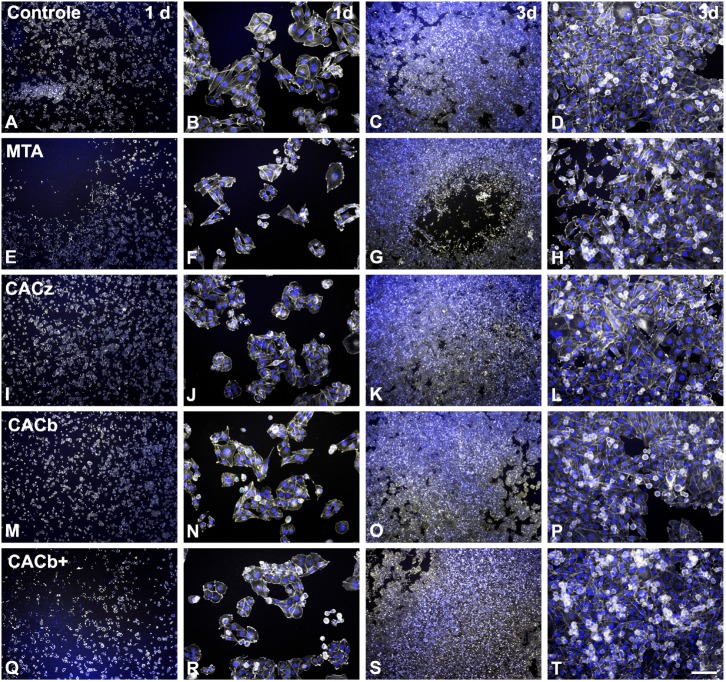
Morphological aspects of MDPC-23 odontoblast-like cell cultures exposed or not (Control, A-D) to MTA (E-H), CACz (I-L), CACb (M-P), or CACb+ (Q-T) cements at days 1 (A, B, E, F, I, J, M, N, Q, R) and 3 (C, D, G, H, K, L, O, P, S, T). Green fluorescence (grayscale mode) indicates the actin cytoskeleton, and blue fluorescence, cell nuclei. Scale bar= 800 μm for A, C, E, G, I, K, M, O, Q, and S; 100 μm for B, D, F, H, J, L, N, P, R, and T